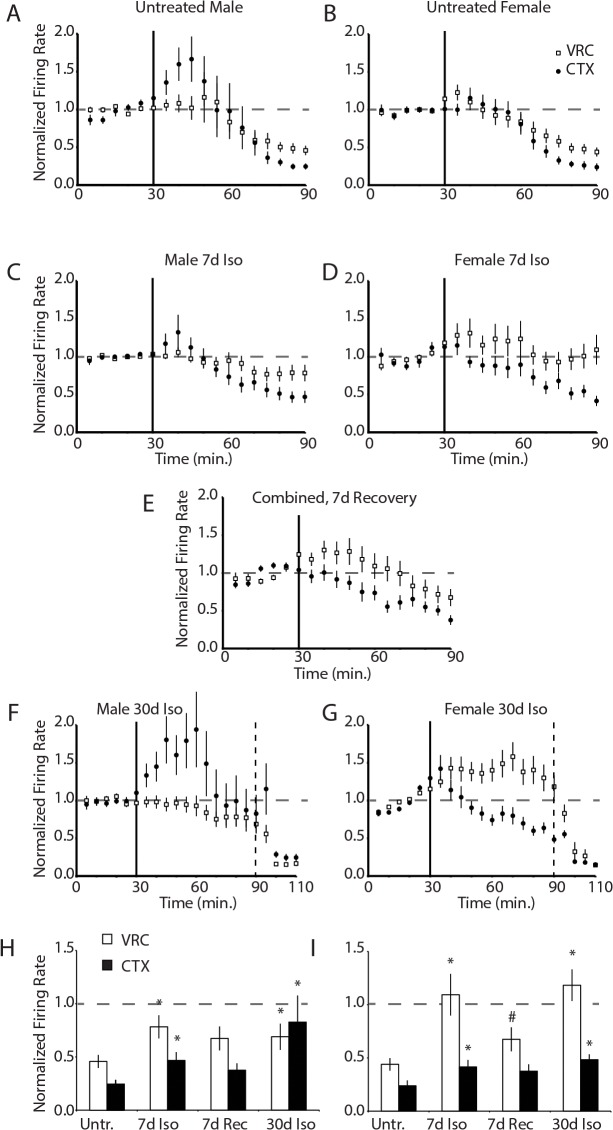
Spontaneous neuronal activity resistance to bath-applied pentobarbital in medullary and cortical slices from 7d isoflurane-treated rats.Spontaneous activity of neurons in the region anatomically consistent with the VRC and PreBötC (all labeled as VRC neurons) are insensitive to bath-applied pentobarbital (300 μM) following 7d isoflurane treatment. A, Mean normalized firing rate of VRC (n = 62, open circles) and CTX (n = 37, filled circles) neurons from male rats in response to 300 μM pentobarbital (applied at vertical bar, t = 30 min). B, Pentobarbital had equivalent depressive effects on VRC (n = 37) and CTX (n = 47) neurons from virgin female rats. C, Following pentobarbital treatment, spontaneous activity of VRC neurons (n = 62) from male rats treated with intermittent isoflurane for 7d were significantly more active than VRC neurons from untreated control rats. The response of cortical neurons (n = 49) to pentobarbital was non-significantly shifted in the same direction. D, Likewise, in female rats treated with isoflurane for 7d, pentobarbital failed to inhibit spontaneous neuronal activity in the VRC neurons (n = 40). CTX neurons (n = 51) trended non-significantly towards an increase in activity compared to untreated control female rats. E, This effect was reversible, as 7d of recovery following 7d of intermittent isoflurane shifted spontaneous activity of VRC (n = 27) and CTX neurons (n = 38) in rats toward baseline values. F., 30d of intermittent isoflurane significantly attenuated the pentobarbital response in VRC (n = 40) and CTX neurons (n = 32) in male rats. To confirm the presence of pentobarbital-insensitive GABAARs, muscimol (20 μM) was applied at 90 min (dashed vertical line). Nearly all neurons that were resistant to pentobarbital were inhibited by muscimol. G, In female rats exposed to 30d isoflurane treatment, the response of VRC (n = 123) and CTX (n = 83) neurons to pentobarbital was significantly attenuated. These neurons were also silenced by muscimol (dashed vertical line). (H,I) The average steady-state responses to bath-applied pentobarbital are quantified for the different isoflurane treatments and recovery for male rats (C) and female rats (D). The asterisk indicates p<0.05 for comparison to control while the pound sign indicates p<0.05 for comparison to 7d treatment.